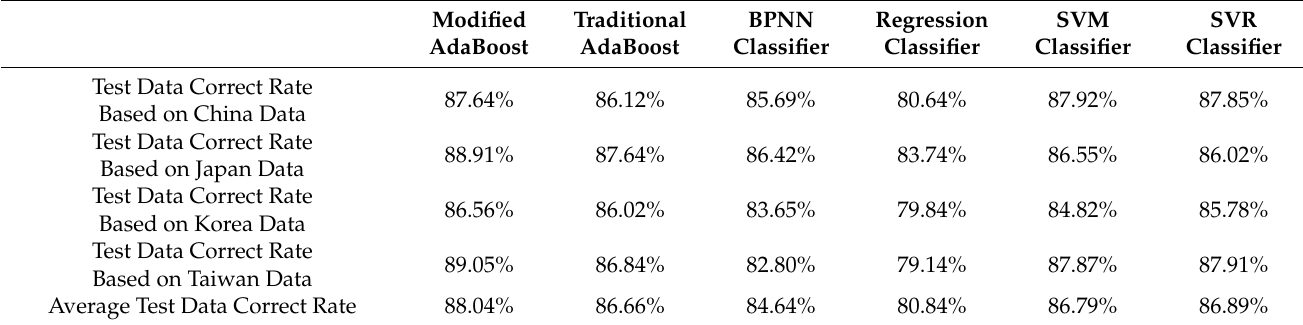
Table 4. Predictive ability of the modified AdaBoost comparison in different kinds of machine learning methods in two-class classification.